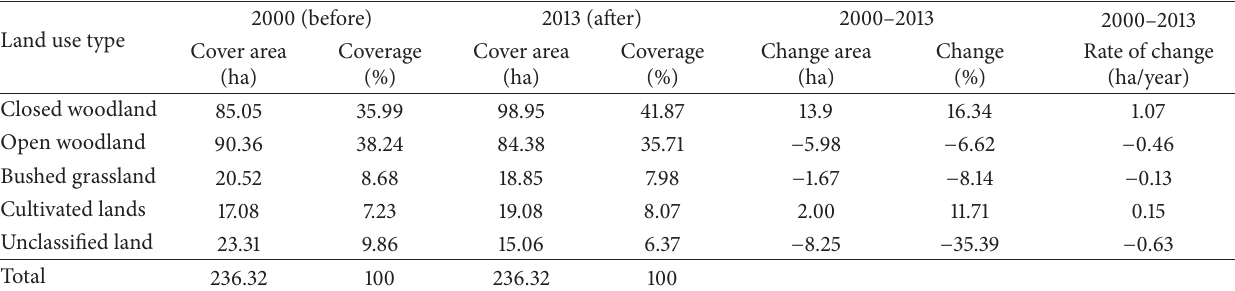
Table 7: Land use and miombo cover change before and after CBFM in Mandumburu.